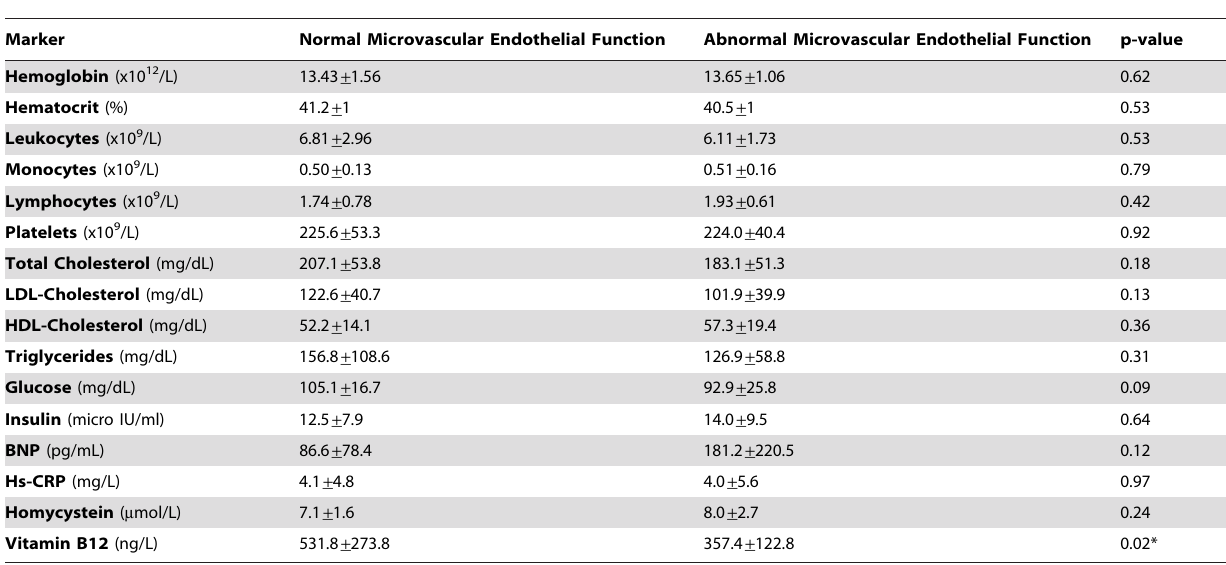
Table 2. Surrogate markers for coronary heart disease (CHD) shown divided between those with endothelial dysfunction and those